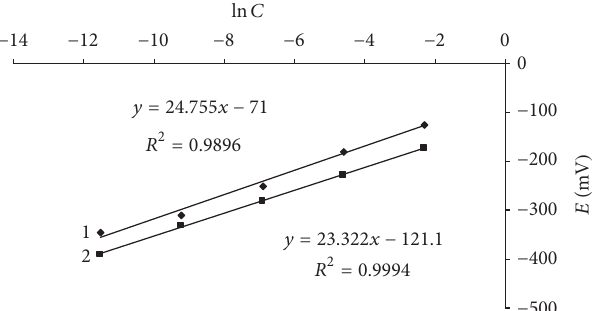
F 7: Potentiometric curves for the titration of